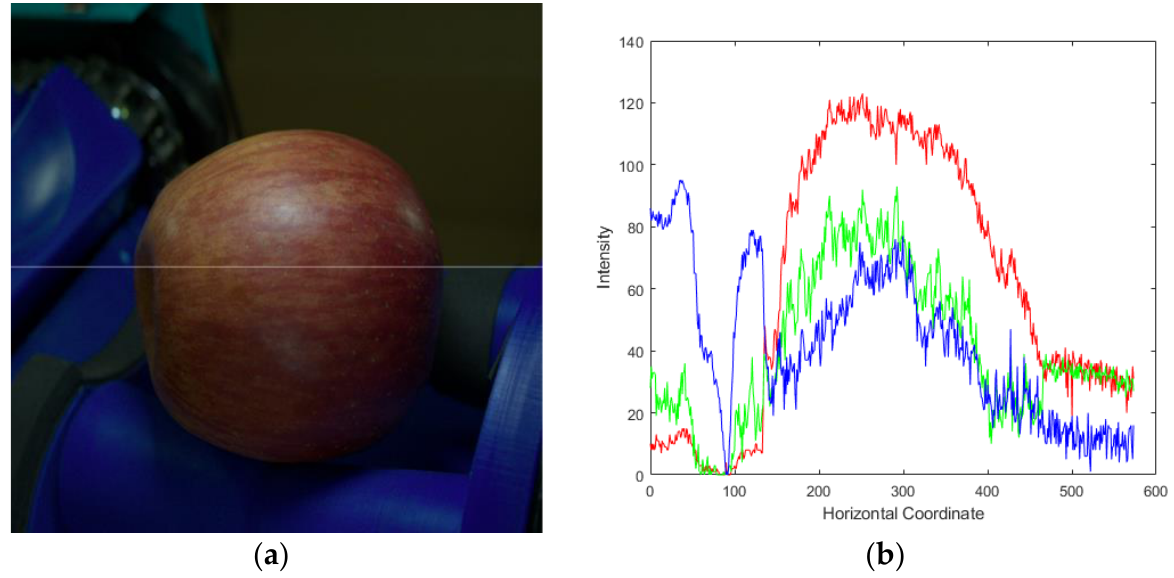
Figure 6. Example of analysis of the RGB histogram of apples: ( a ) sample image; ( b ) RGB histogram.